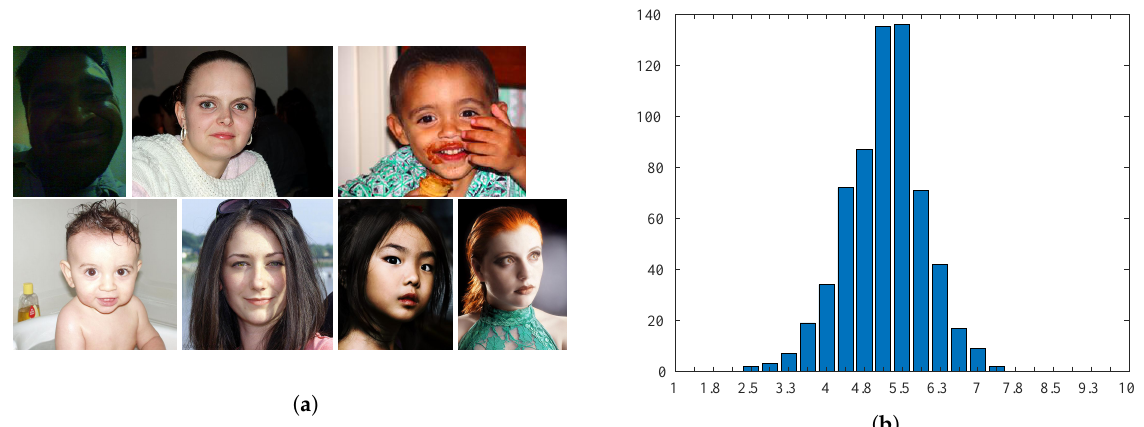
Figure 10. Sample images and distribution of scores for the Face Aesthetics Visual Analysis (FAVA) database. ( a ) Samples are sorted from by their aesthetic score (increasing from top left to bottom right). ( b ) Distribution of ground-truth scores.